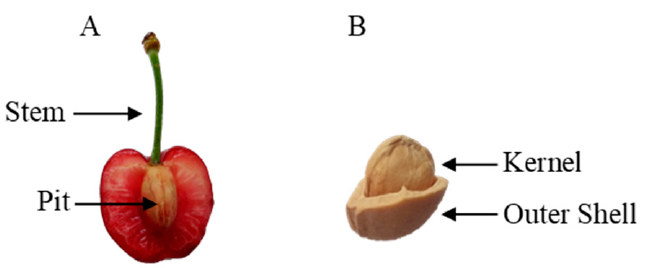
Figure 1. Unvalued sweet cherry by-products: view of sweet cherry stem and pit ( A ) and view of sweet cherry pit ( B ).